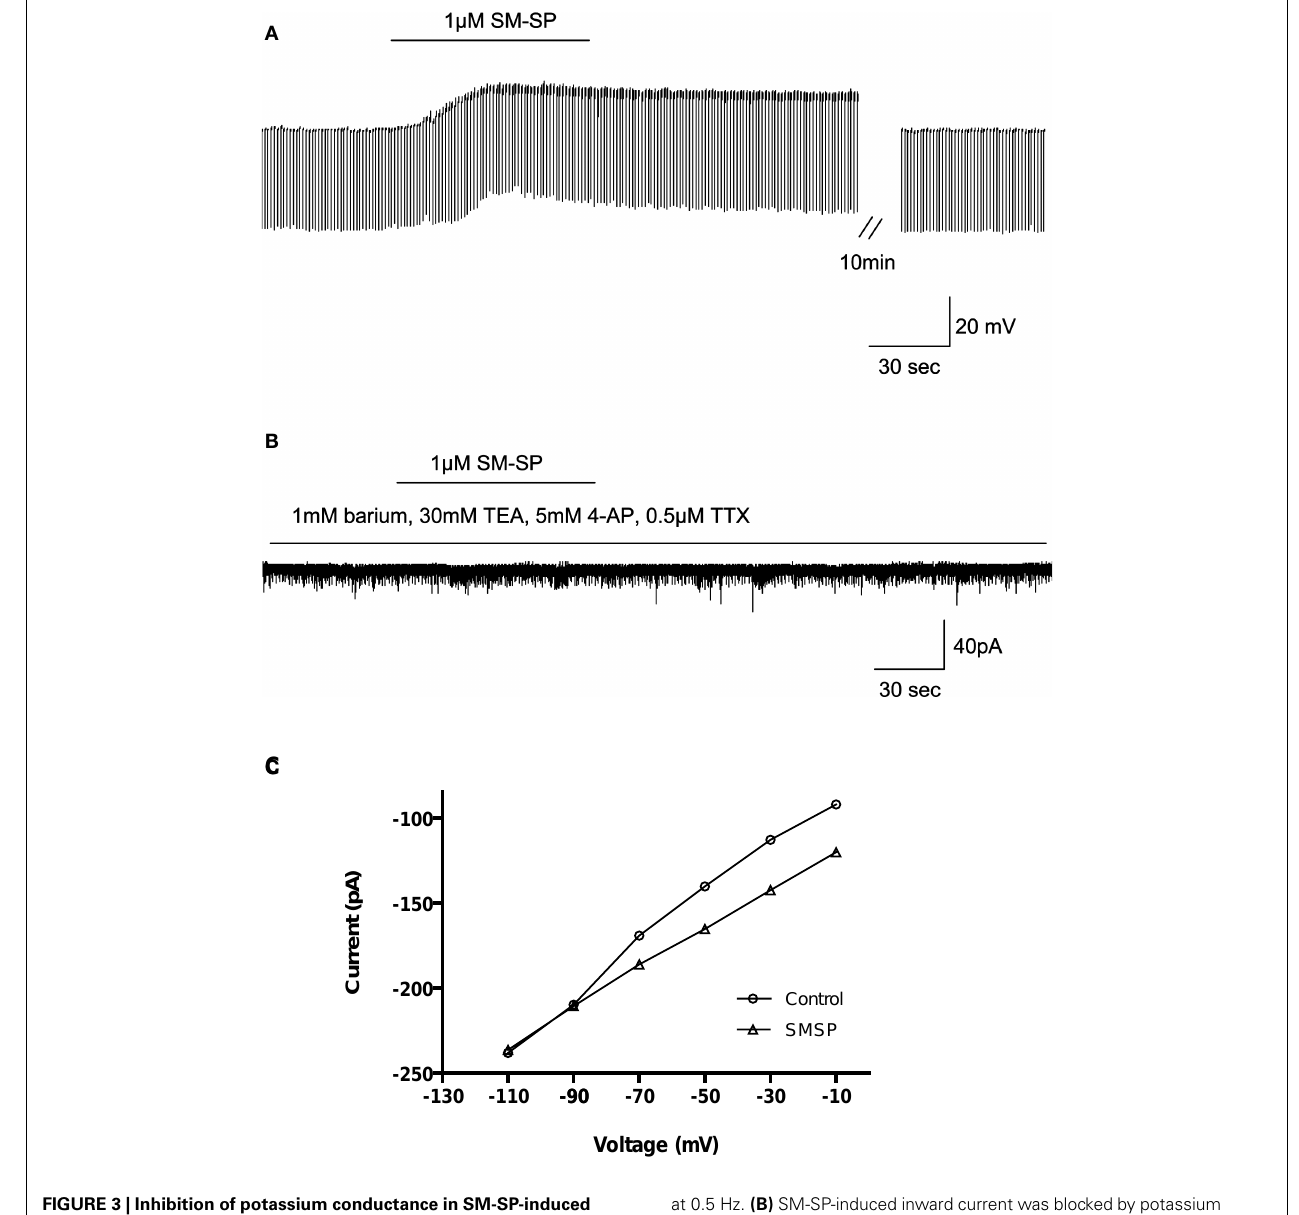
at 0.5 Hz. (B) SM-SP-induced inward current was blocked by potassium channel blockers. (C) A typical current-voltage relationship revealed the decrease in membrane conductance induced by SM-SP with a reversal potential at − 96